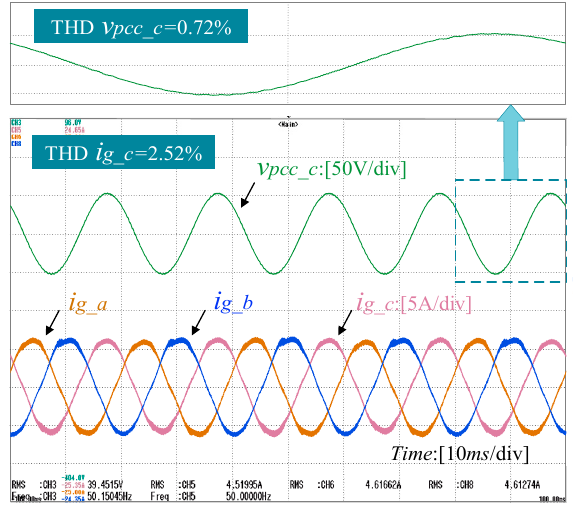
Figure 19. Steady ‐ state responses when Lg is 0 mH.